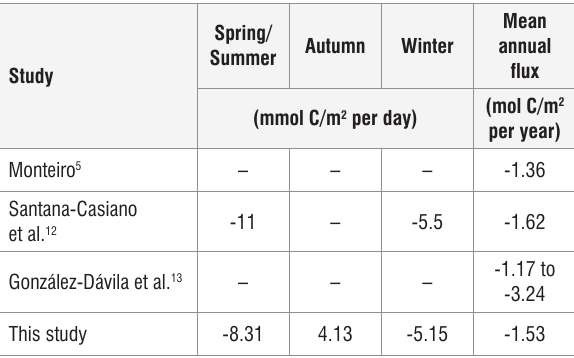
in the surface are shown 2